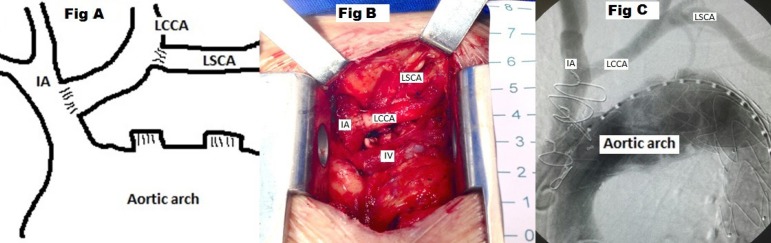
Debranching to zone 1: scheme (A), intraoperative picture (B) and
angiography confirming patency and endograft position without
endoleaks (C). IA=innominate artery; IV=innominate vein; LCCA=left
common carotid artery; LSCA=left subclavian artery